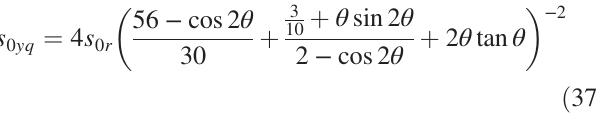
FIG. 12. Dipole bunch wake for a Gaussian beam with σ 10 μ m offset in the RadiaBeam/LCLS dechirper. The offset is y ¼ 0 . 5 mm and the half-aperture is the nominal a ¼ 0 . 7 mm. Given are the numerical results of ECHO(2D) (blue), and the analytical zeroth order (red) and 1st order results (green). The bunch shape λ ð s Þ with the head to the left is shown in black.